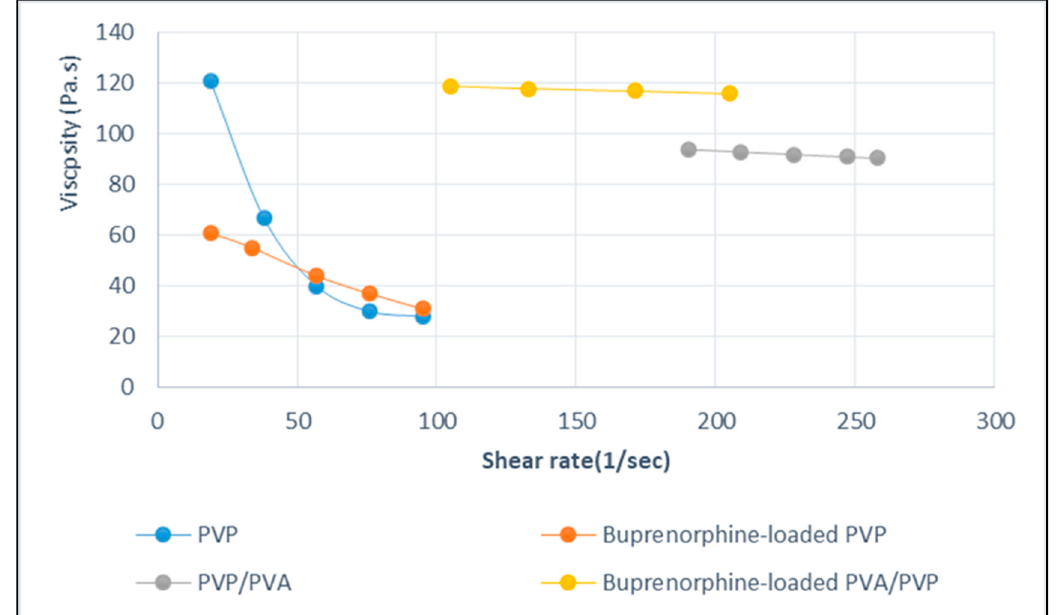
Figure 5. Viscosity versus the shear rate of electrospinning solutions.